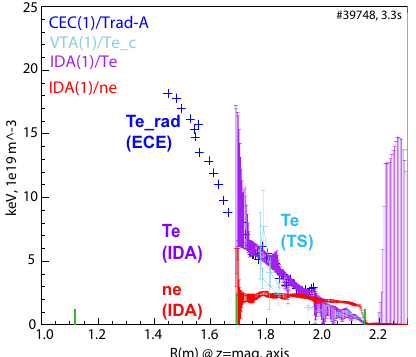
Figure 6. n e and T e profiles for AUG #39748 closest to 3.3s, no time averaging. T e data from Thomson scattering (TS) and ECE-emission ( T e , rad ). The integrated data analysis (IDA) used the low field side (LFS) ECE data for T e and the interferometry and Lithium-beam data for n e